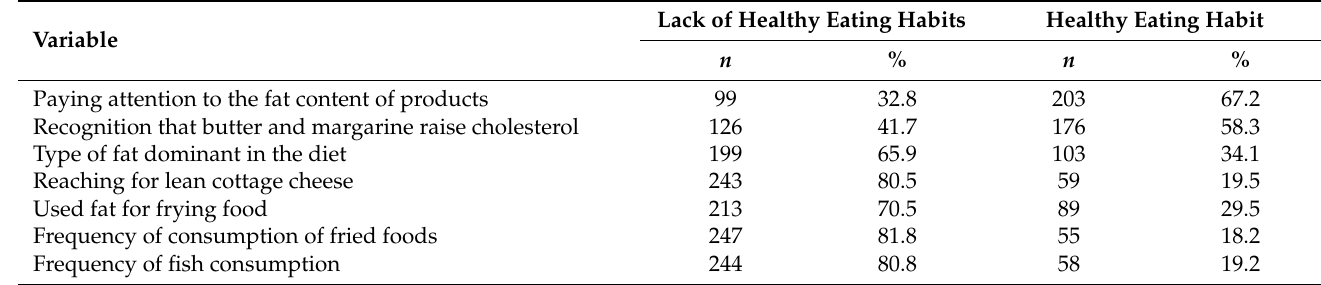
Table 2. Share of responses indicating healthy eating habits and lack thereof.